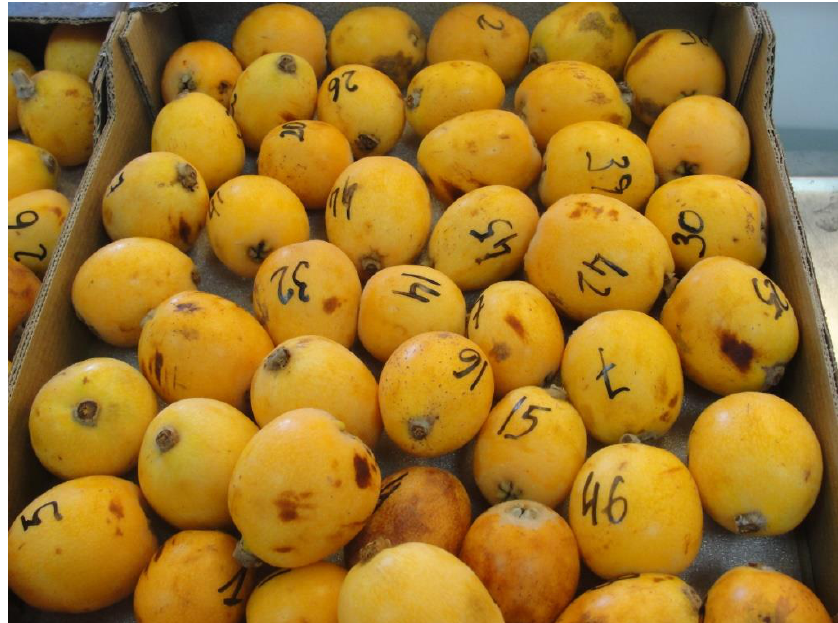
Figure 2. Tagged fruit undergoing handling performance evaluation in a packinghouse.